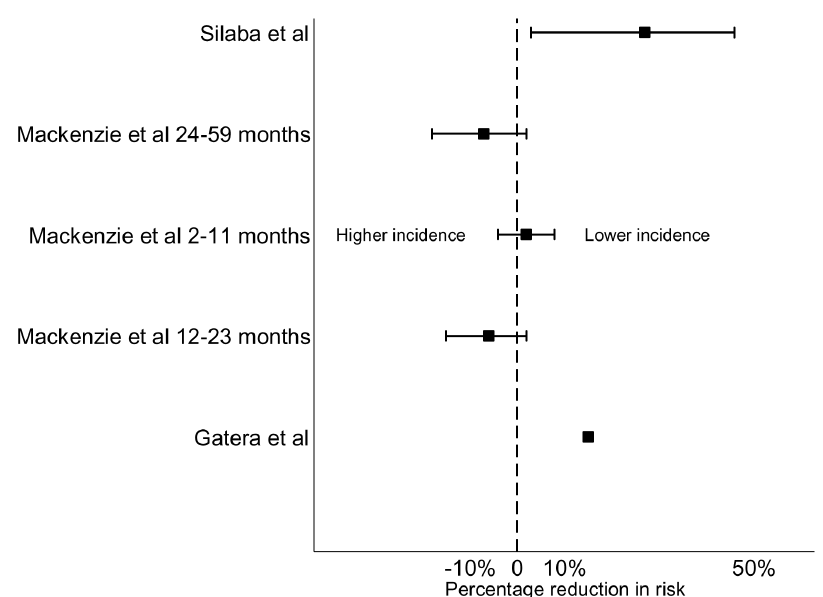
population.Figure 2. Forest plot showing the percentage risk reduction in clinical pneumonia incidence in included studies and